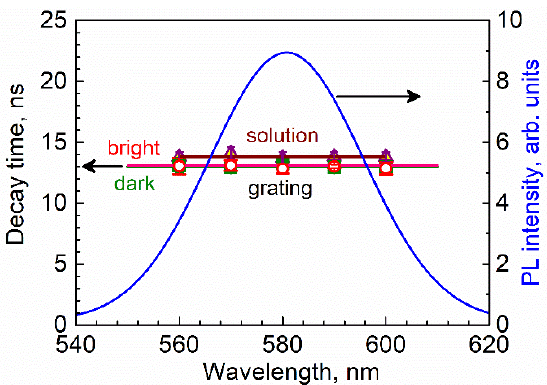
Figure 10. Average QD PL decay times in the bright (open symbols) and dark (full symbols) stripes of the grating and in a solution vs. the acquisition wavelength within the QDs’ PL band. The Gaussian representation of the PL spectrum is shown with blue line.